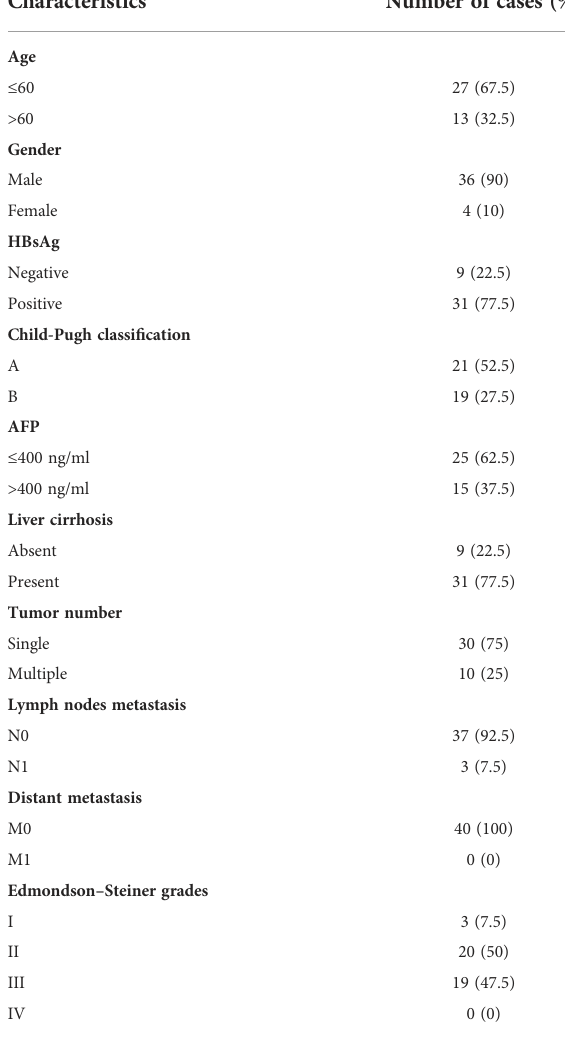
TABLE 1 Clinical and pathological features of HCC